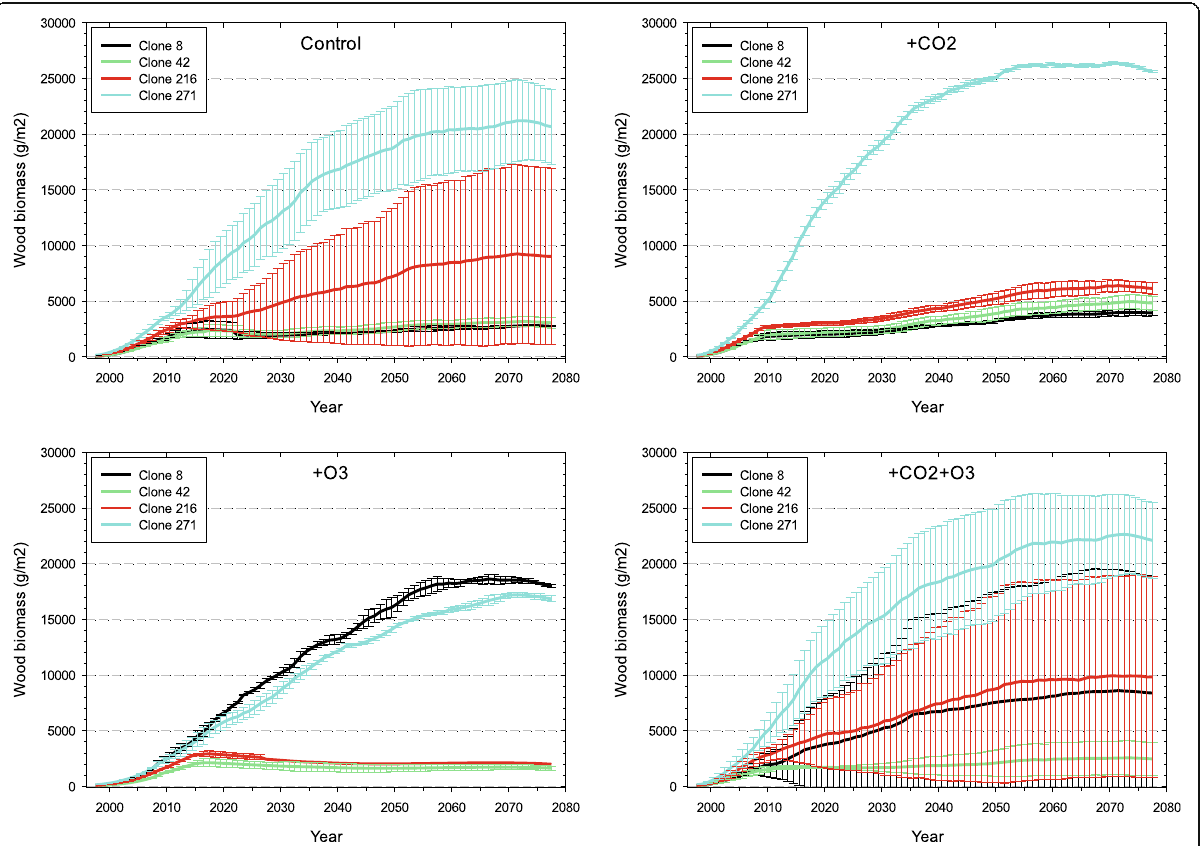
Fig. 5 Extrapolation by simulation 80 years into the future of the aspen section of the Aspen-FACE experiment. Error bars show one standard deviation of three